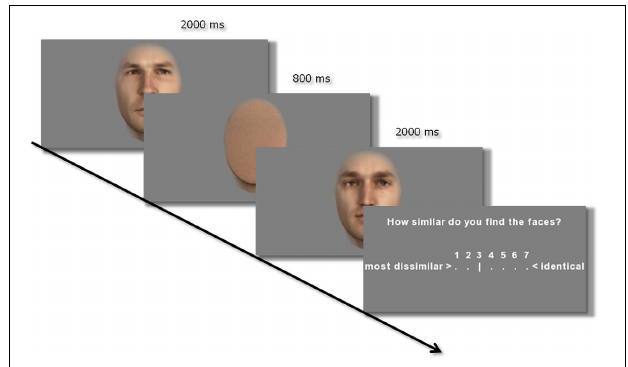
FIGURE 5 | Example of one trial of the similarity rating task. Both faces in a trial always belong to the same set.